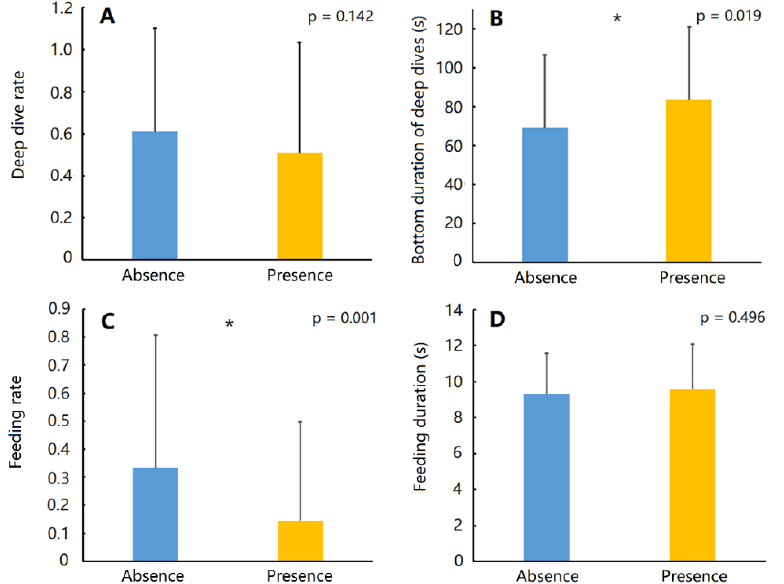
Figure 5. Histograms (mean and standard deviation) showing ( A ) deep dive rate, ( B ) bottom duration of deep dives, ( C ) feeding rate and ( D ) feeding duration, for the absence and presence of the anthropogenic whale-approaching (AWA) activities, respectively. The histograms with symbol ‘*’ refer to significant results at p < 0.05.